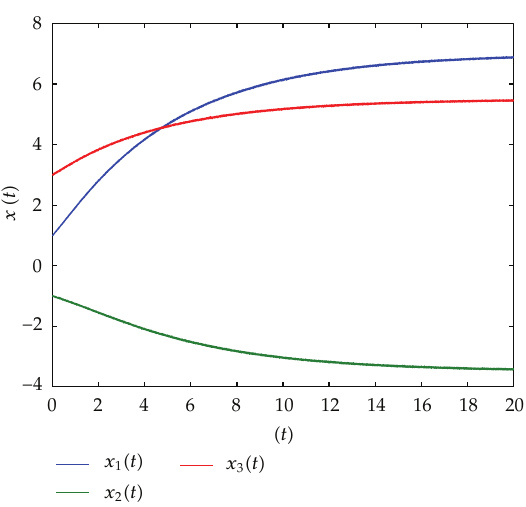
Figure 1: Trajectories of SNN (cid:2) 4.1 (cid:3) without any controller in Example